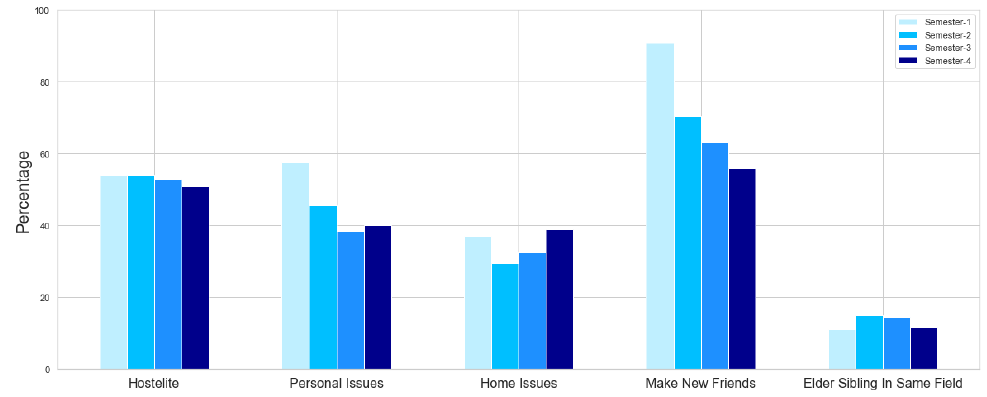
Figure 2. Semester-wise Behavioral features of Students (1).